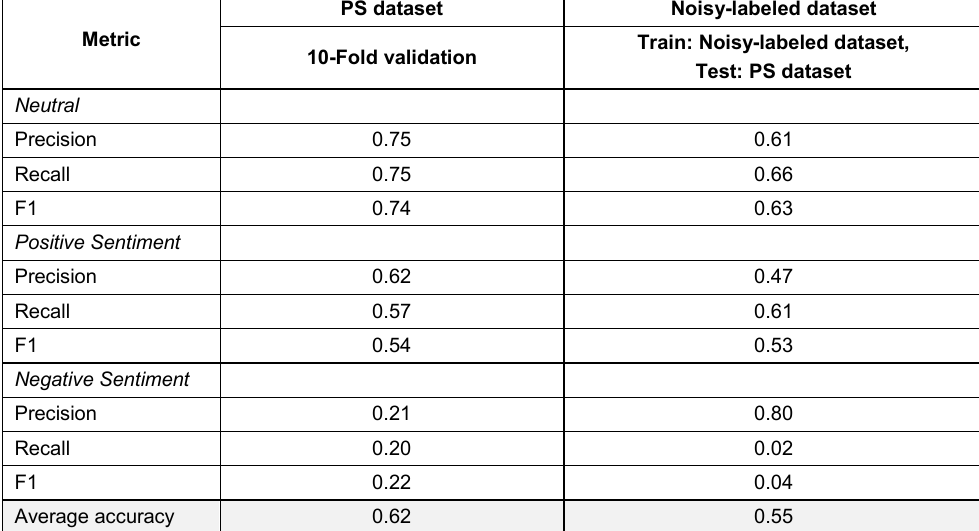
Table 4. NB classifier performance with PS and noisy-labeled dataset